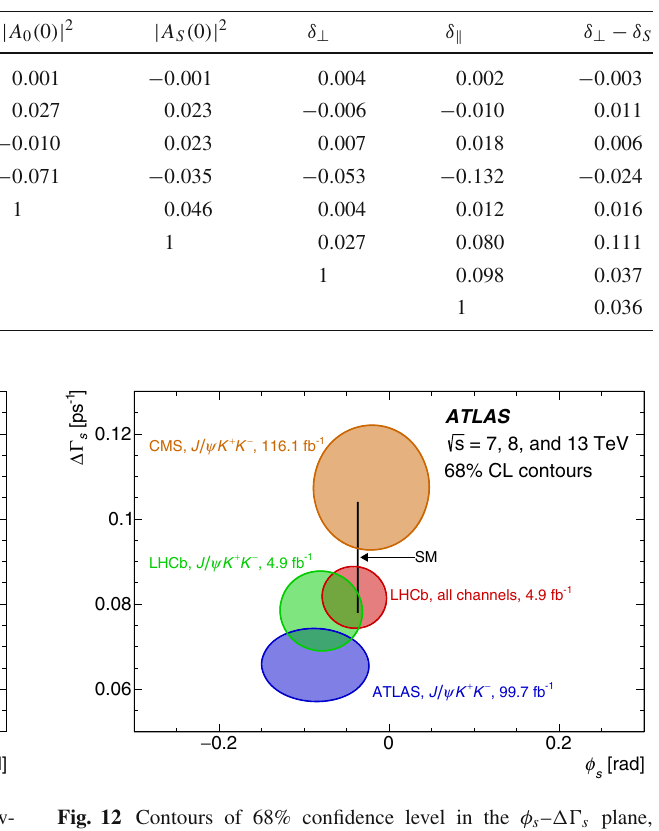
Fig. 11 Contours of 68% confidence level in the φ s – (cid:5)(cid:6) s plane, show- ing ATLAS results for 7 and 8 TeV data (blue dashed-dotted curve), for 13 TeV data (green dashed curve) and for 13 TeV data combined with 7 and 8 TeV (red solid curve) data. The Standard Model prediction [5,52] is shown as a very thin black rectangle. In all contours the statistical and systematic uncertainties are combined in quadrature and correla- tions are taken into account